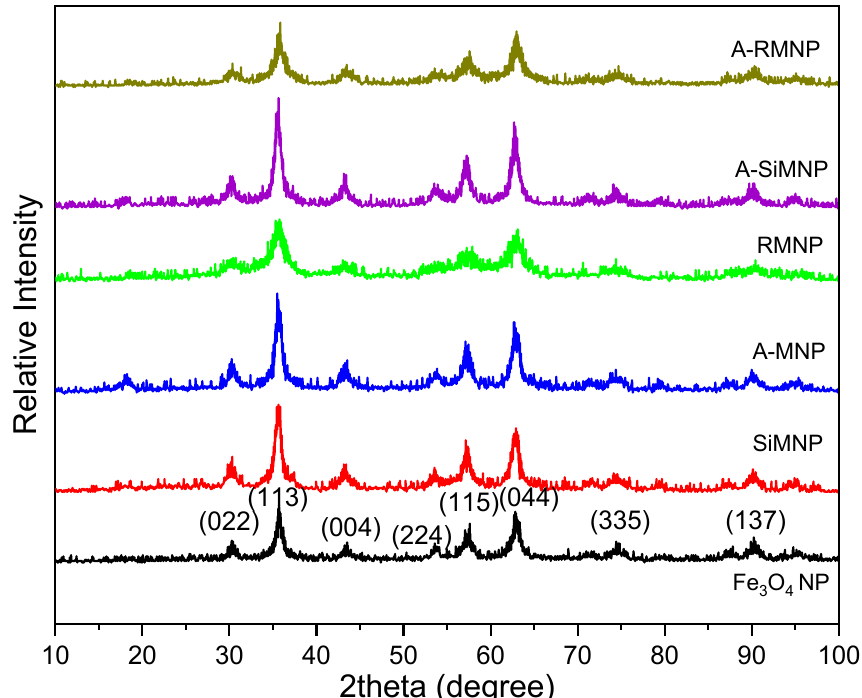
Figure 2. XRD patterns of MNP, SiMNP, A-MNP, RMNP, A-SiMNP, and A-RMNP obtained at room temperature.